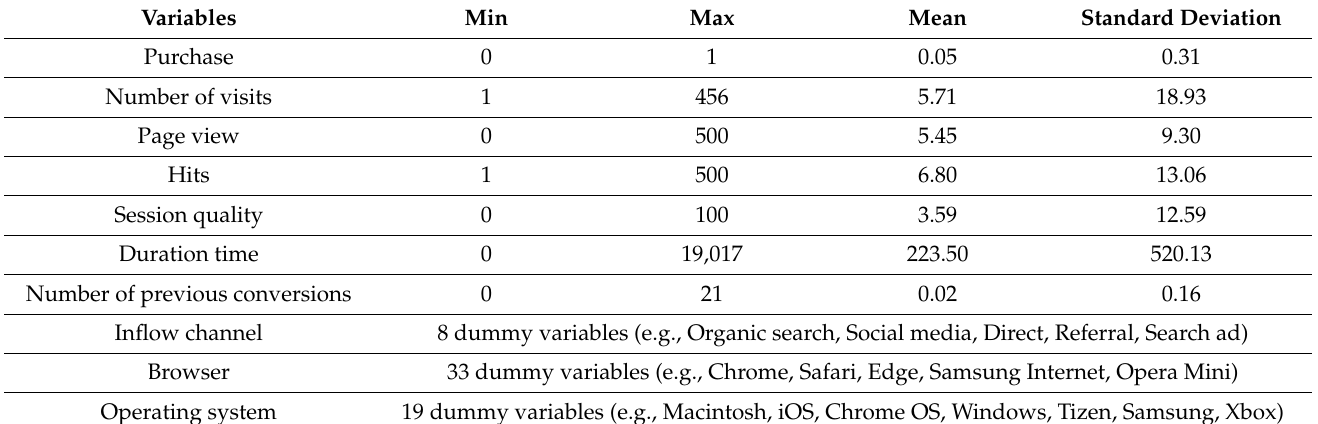
Table 4. Consumer journey